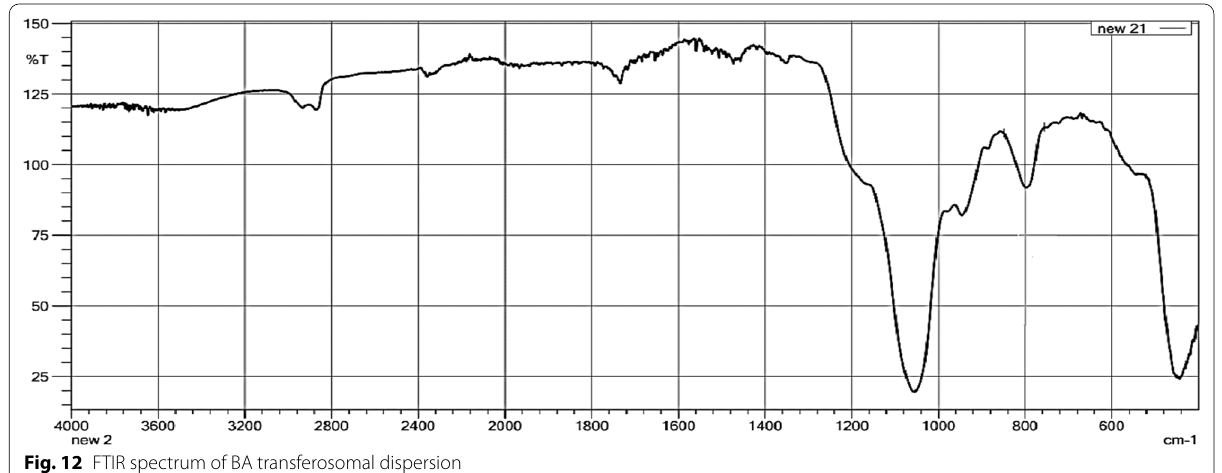
Fig. 12 FTIR spectrum of BA transferosomal dispersion